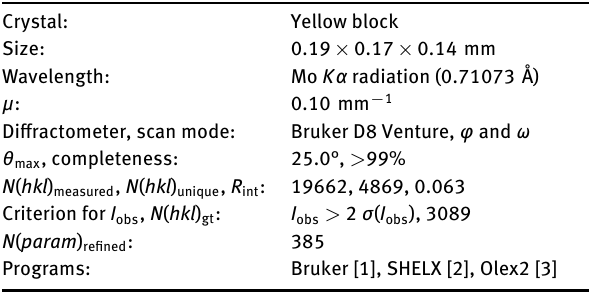
Table 1: Data collection and